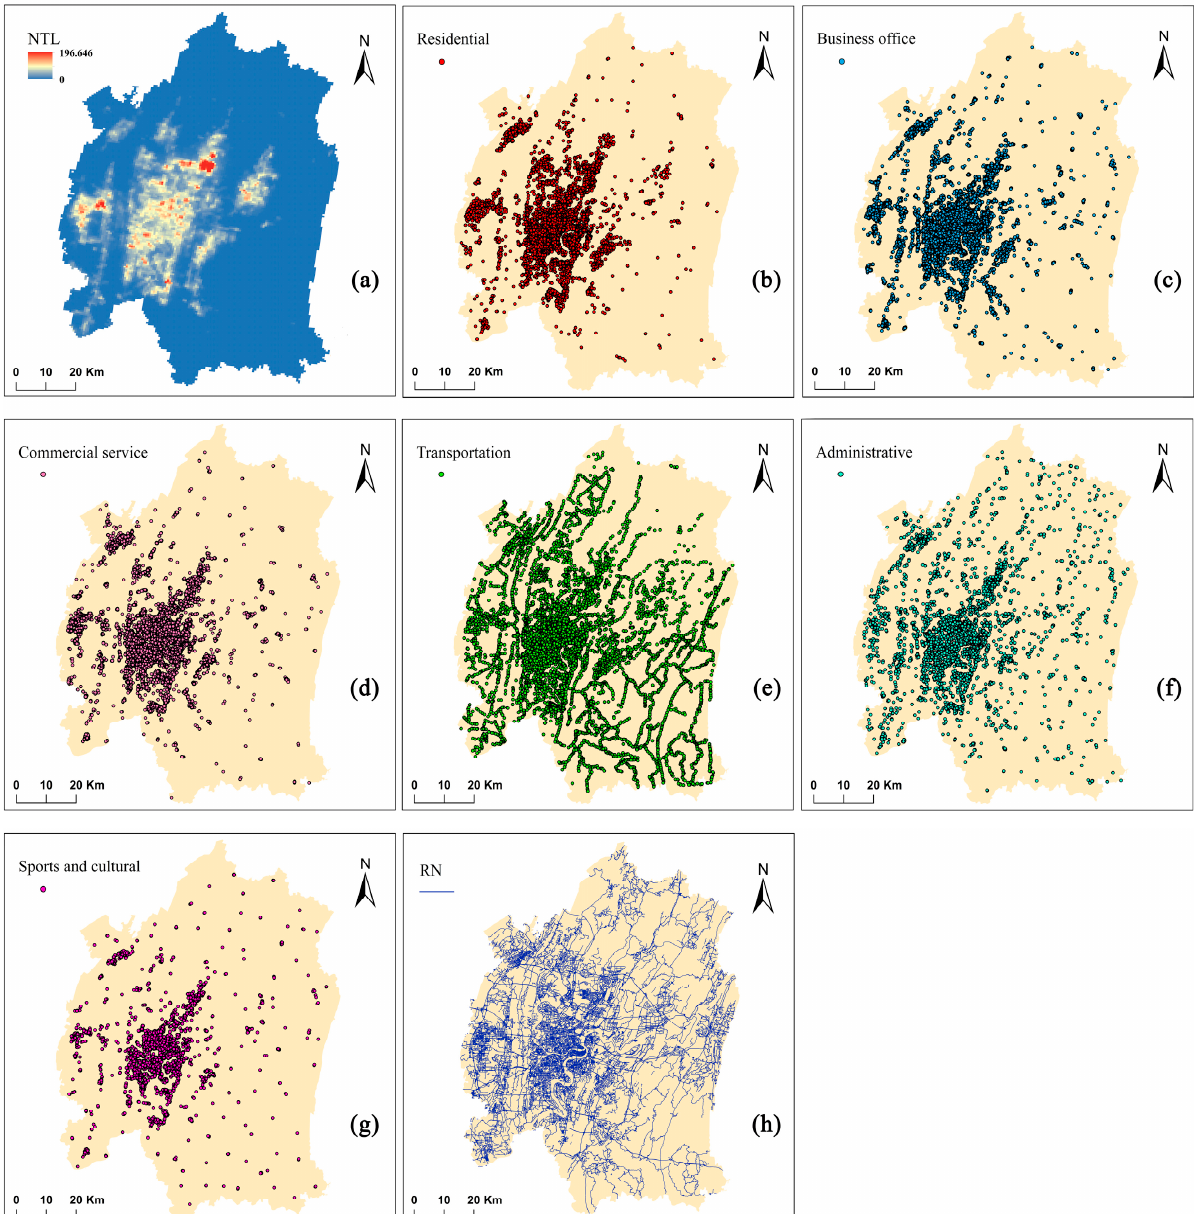
Figure 2. Spatial distribution of data used in this study in 2018: ( a ) NPP/VIIRS NTL image; ( b ) residential POI data; ( c ) businesses office POI data; ( d ) commercial service POI data; ( e ) transportation POI data; ( f ) administrative POI data; ( g ) sports and cultural POI data and ( h ) road network composed with all levels of roads.